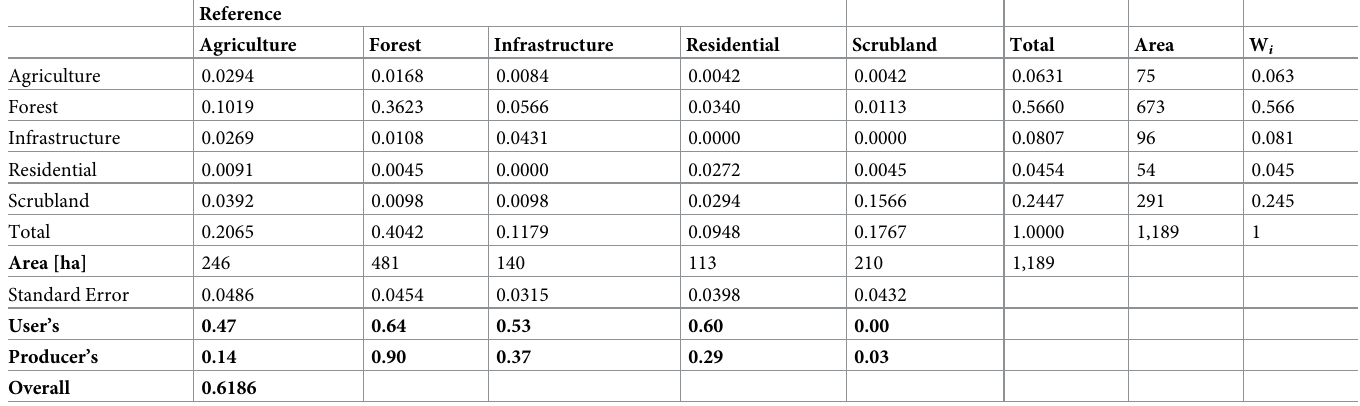
Table 6. Error matrix (area proportion) for 2012 based on stratified random